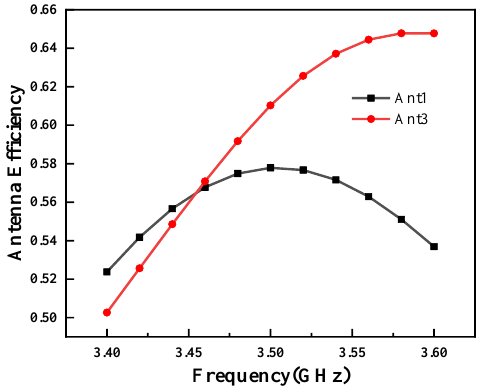
Figure 13. The efficiency of the 8 × 8 MIMO antenna. Figure 14a shows the measured radiation pattern of Ant1 and Ant3 at 3.5 GHz in the XOY plane. As shown in Figure 14a, the radiation zero point of Ant1 is at the center of the antenna, and the radiated energy is concentrated in the positive and negative di- rections of the X axis, while the Ant3 has the largest radiation energy at the center, but due to the effect of the metal floor, the energy is concentrated in the +Y direction.